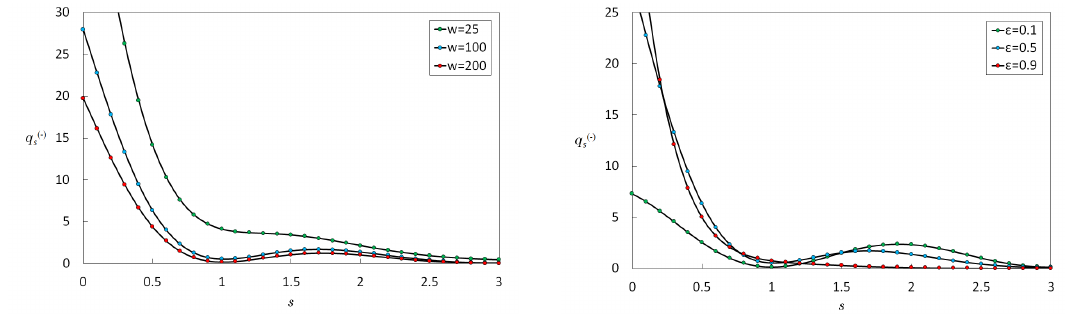
( − ) = 0.5. ( Right ) ε changes, s on s . ( Left ) w changes, ε